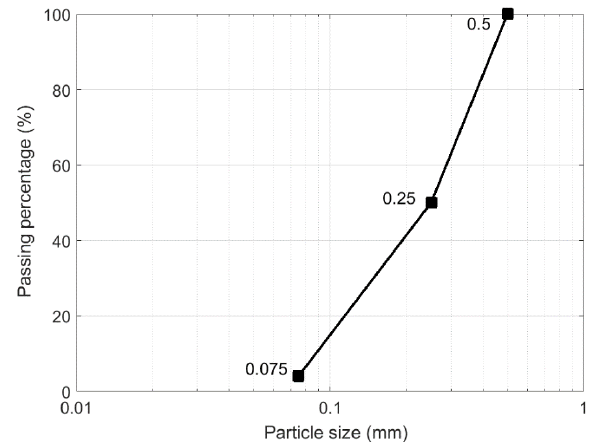
Figure 2. The particle size distribution of the formulated sand samples.